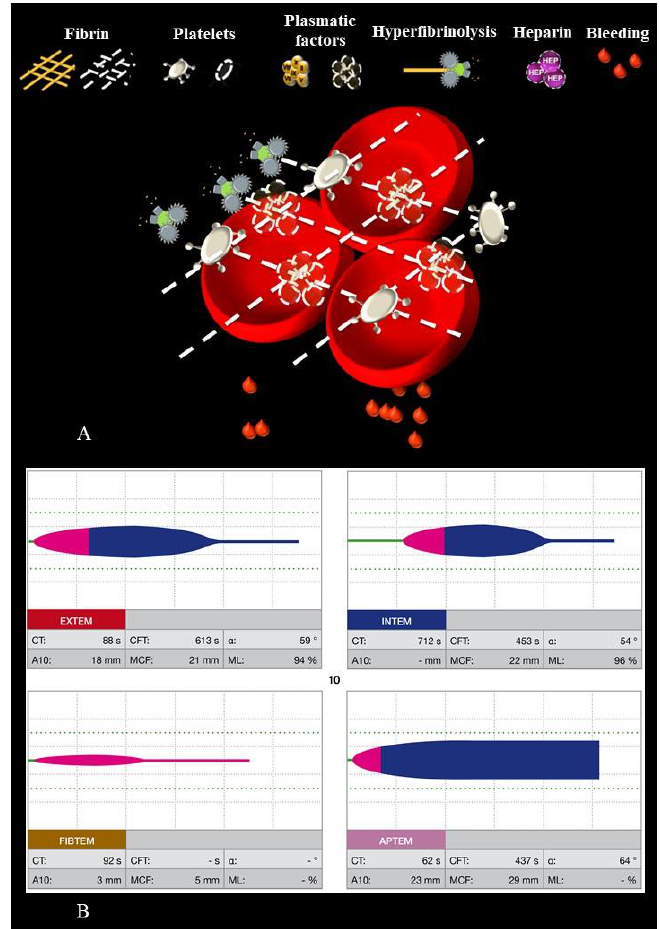
Figure 1. Combined plasmatic factors and fibrin deficiency, hyperfibrinolysis shown as Visual Clot and ROTEM. ( A ): Visual Clot with fibrin deficiency displayed as dashed lines, deficiency of plasmatic factors displayed as dashed lines and hyperfibrinolysis. ( B ): corresponding ROTEM with EXTEM, INTEM, FIBTEM and APTEM. CT = Clotting Time; CFT = Clot Formation Time; MCF = Maximum Clot Firmness; ML = Maximum Lysis.